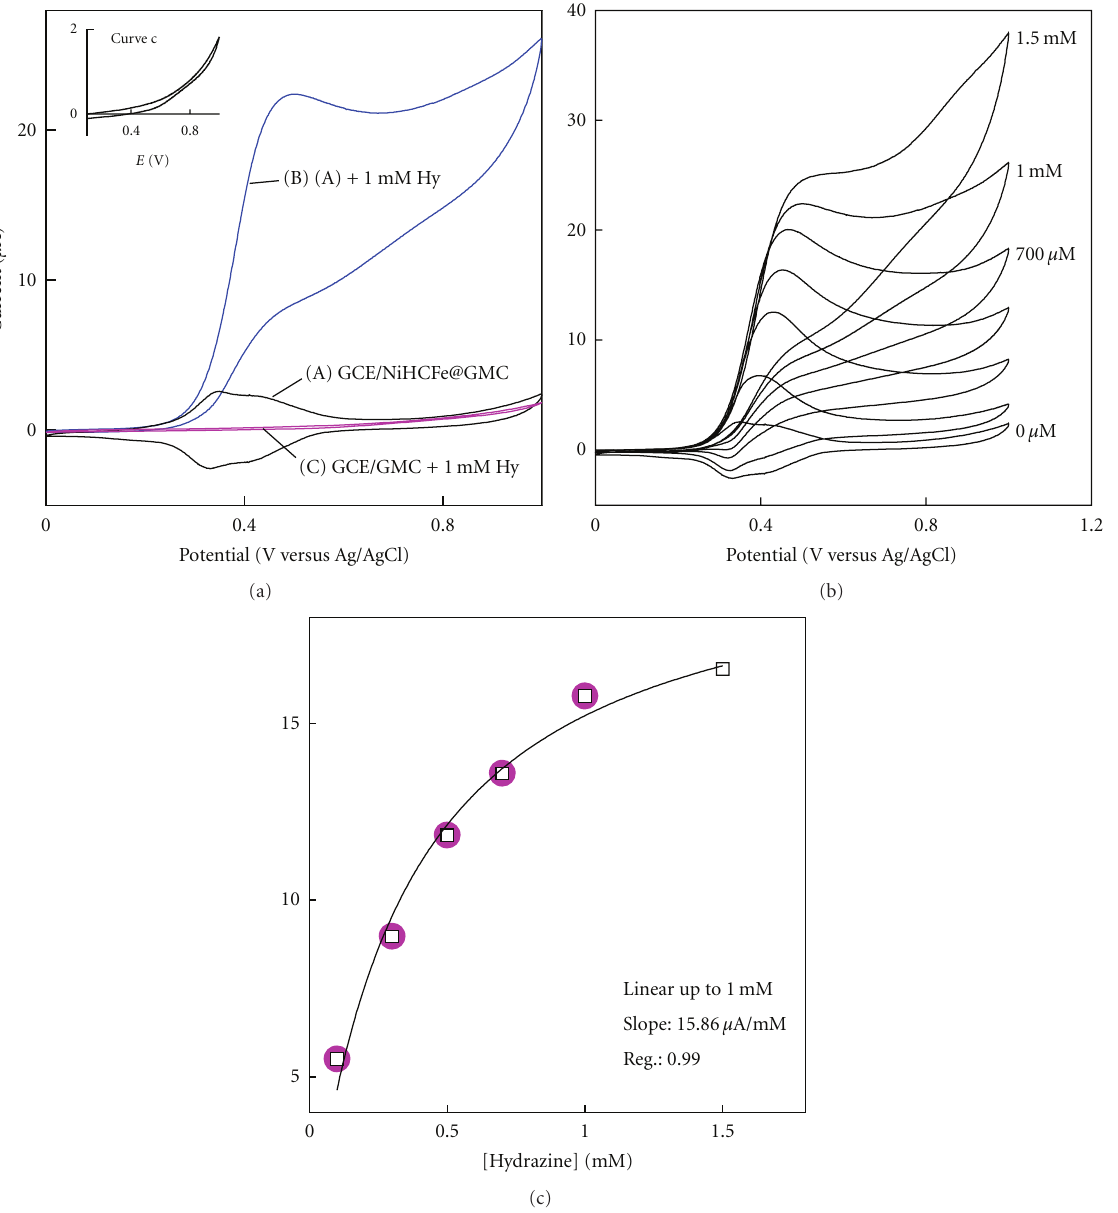
Figure 5: (a) CV responses of GCE/NiHCFe@GMC without and with 1 mM hydrazine (A and B) and GCE/GMC-modified electrode in pre- sence of 1mM hydrazine (C). (b) CV responses of GCE/NiHCFe@GMC with di ff erent concentration of hydrazine. (c) Typical calibration